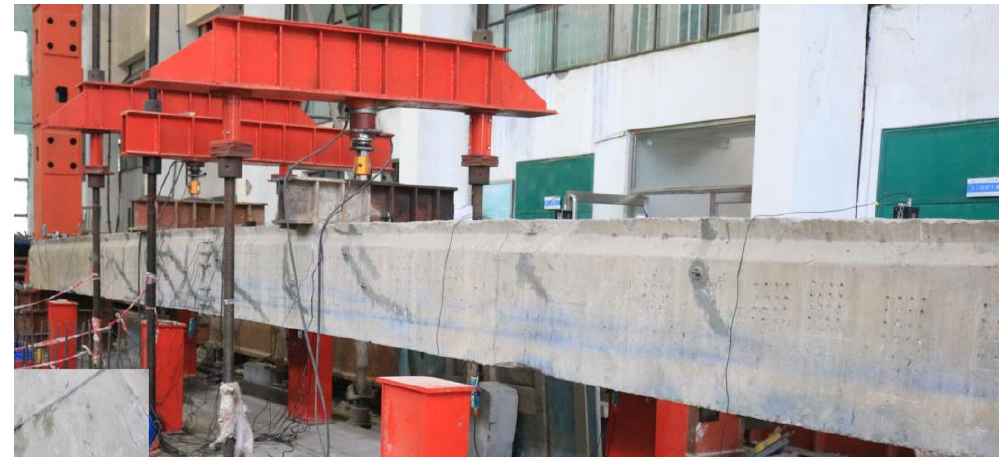
Figure 5. Photo of the repaired beam under four-point bending test.